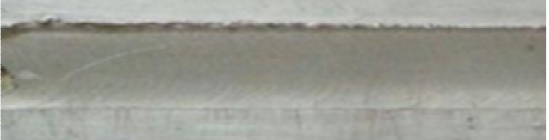
Fig. 8. Variation of flatness plate (BT-20)